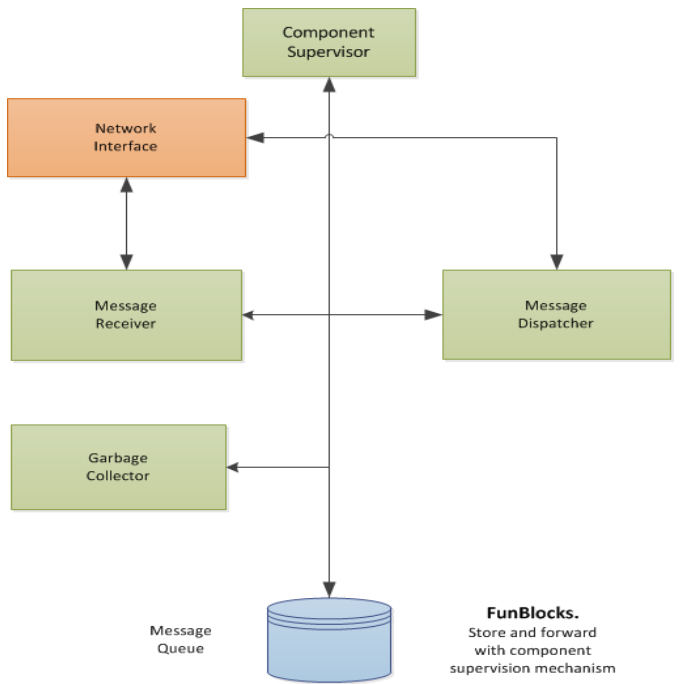
Figure 7. FunBlocks